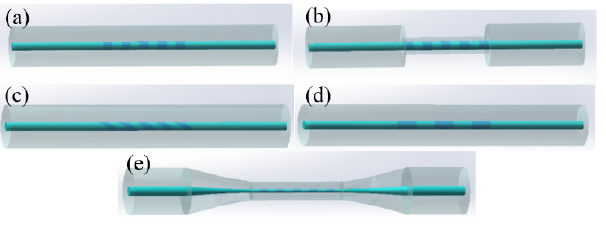
Figure 11. The schematic diagrams of ( a ) FBG, ( b ) etched FBG, ( c ) tilted FBG, ( d ) LPG, and ( e ) tapered fiber